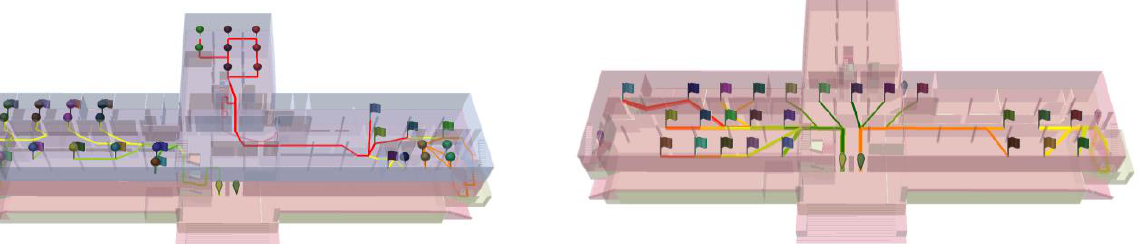
Figure 19. Generated Staff Evacuation Second Floor Routes